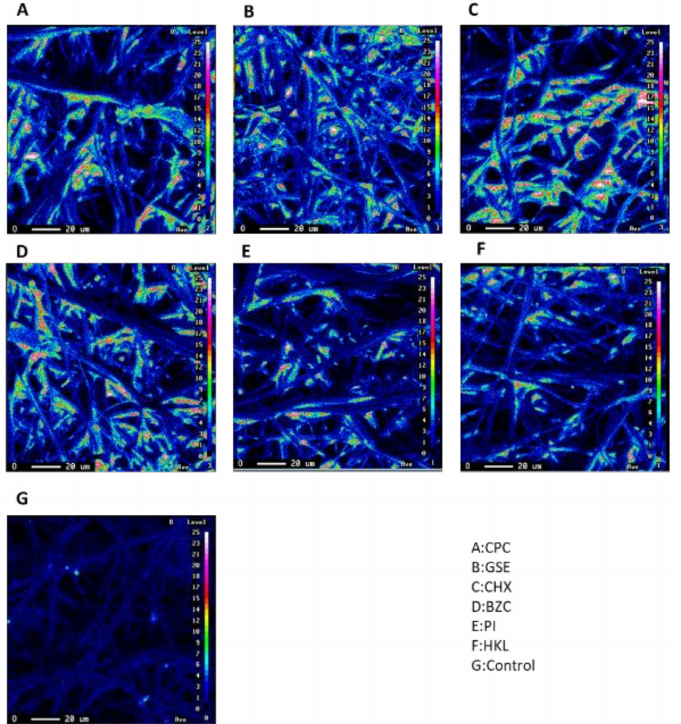
Figure 3. Elemental mapping of the fiber surfaces of non-woven fabric filters treated with CPC ( A ), GSE ( B ), CHX ( C ), BZC ( D ), PI ( E ), or HKL ( F ). The presence of O on the fibers of non-woven fabric filters was confirmed in ( A – F ), but not in ( G )